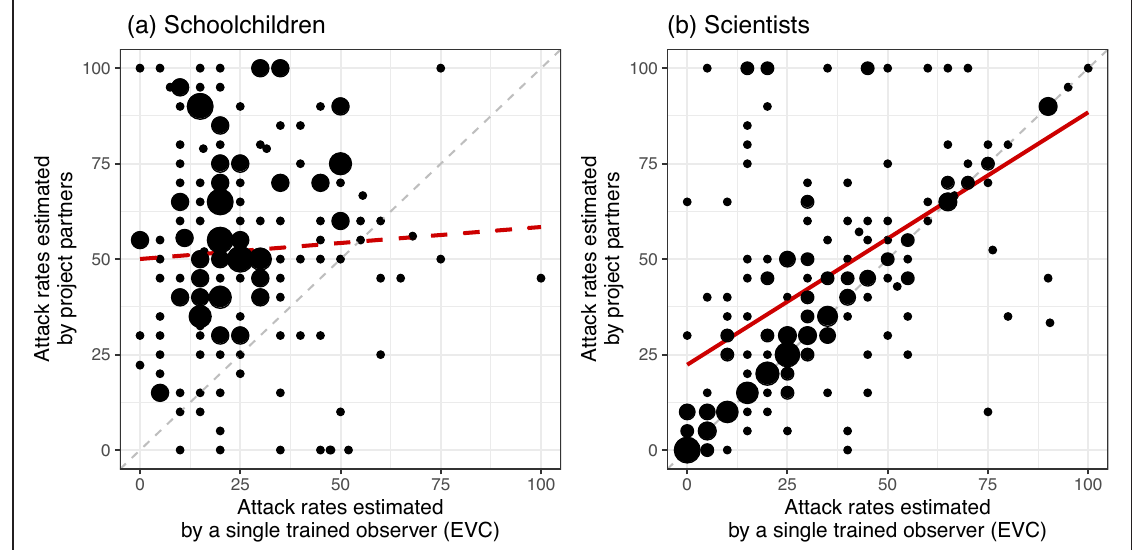
Figure 2: Precision and accuracy of school children (a) and professional scientists (b) in assessing attack rate (% artificial larvae with predation marks). Dots represent attack rate aggregated at the level of oak trees for each survey separately. Dot size is proportional to the number of overlapping dots. Dashed lines indicate a 1:1 relation. In Panel a , the thick dashed red line represents the non-significant regression line (y = 0.08·x + 50.32, marginal R 2 : R m2 < 0.01, conditional R 2 : R c2 = 0.66). In Panel b , the bold red line represents the significant regression line (y = 0.66·x + 23.41, R m2 = 0.31, R c2 = 0.78). EVC, Elena Valdés Correcher (a single professional scientist trained to identify predation marks on artificial